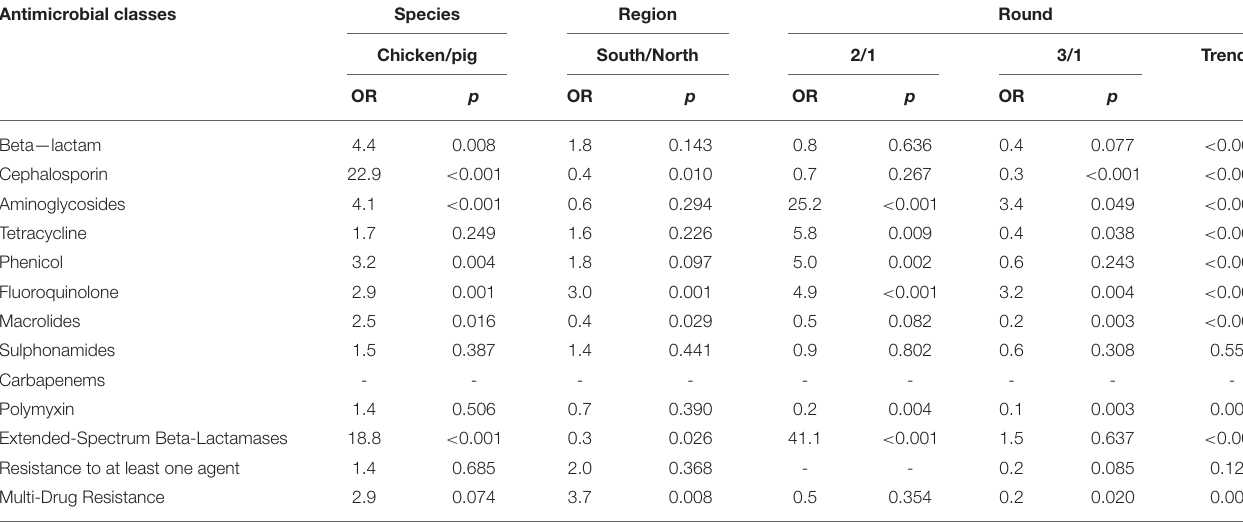
TABLE 3 | Association between non-typhoidal Salmonella resistance, species, region and round, Vietnam, 2017–2019. Antimicrobial classes Species